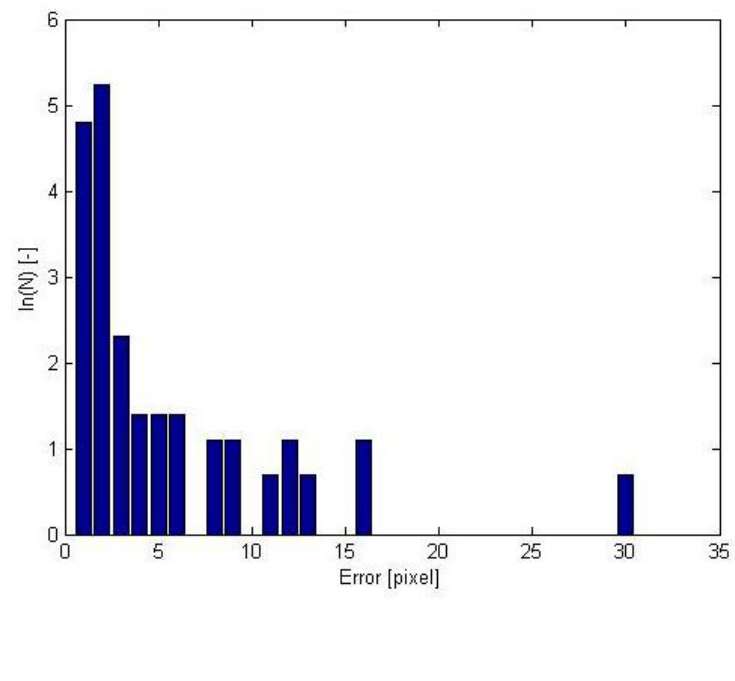
Figure 6. Histogram of the disparity errors of the particles: the natural logarithm of number of particles as a function of disparity